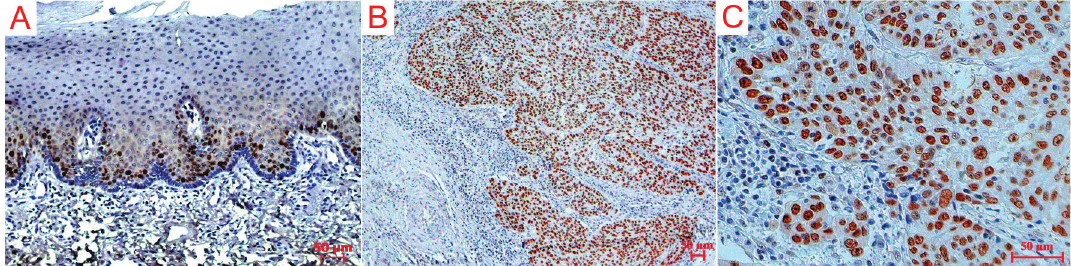
Figure 1- Immunohistochemical expression of MSH2 repair protein in healthy oral mucosa and carcinoma cells of the invasive front of head and neck squamous cell carcinoma (HNSCC). A: Low immunohistochemical expression in basal